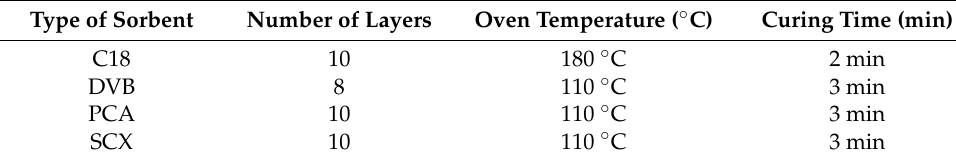
Table 10. Conditions of sorbent application depending on the type of sorbent. Type of